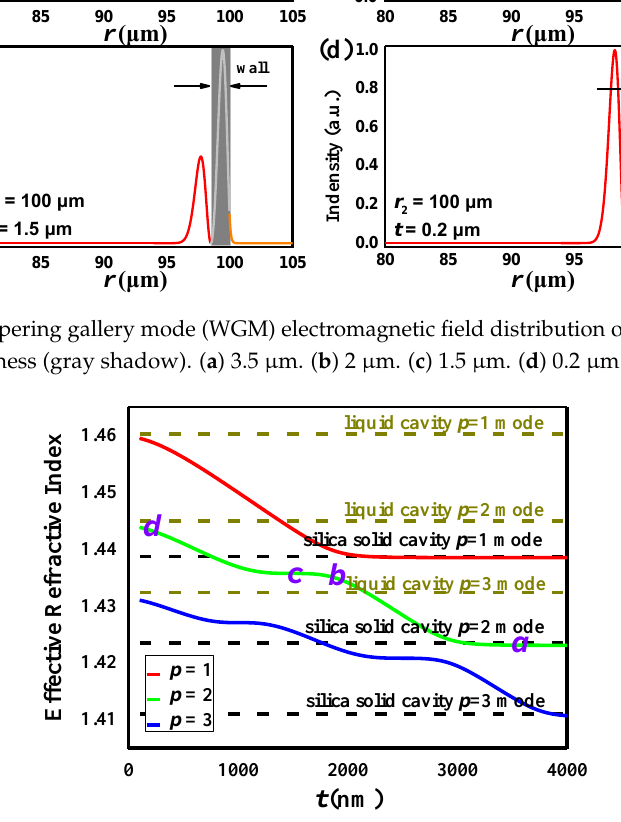
Figure 3. The effective refractive index as a function of the shell thickness for the first three radial WGM. The points (a, b, c, d) in the figure corresponds to Figure 2.